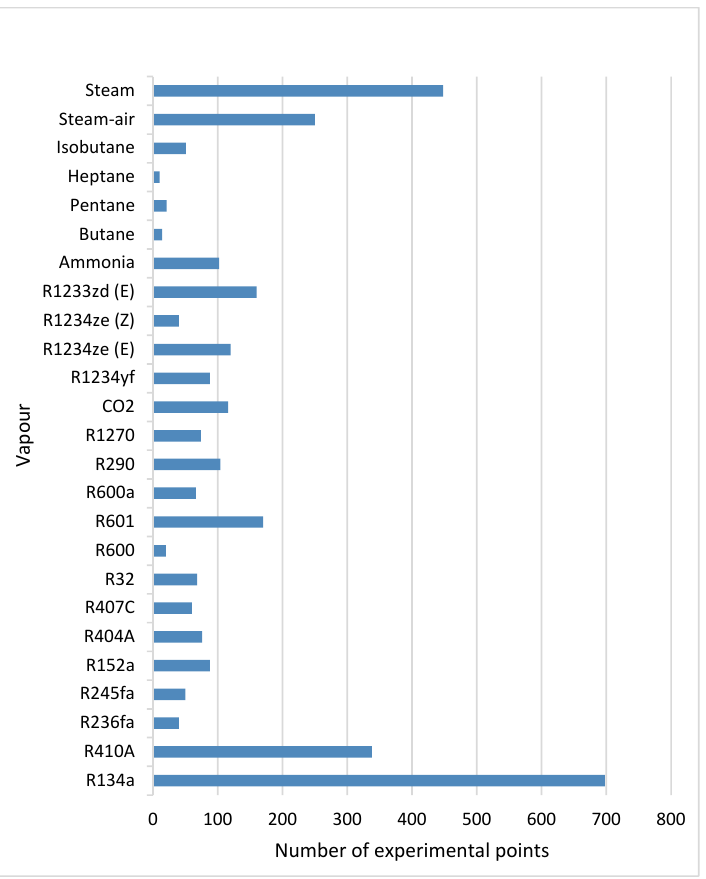
Figure 4. The number of experimental points data received in studies of PHEs with different condensing vapours.